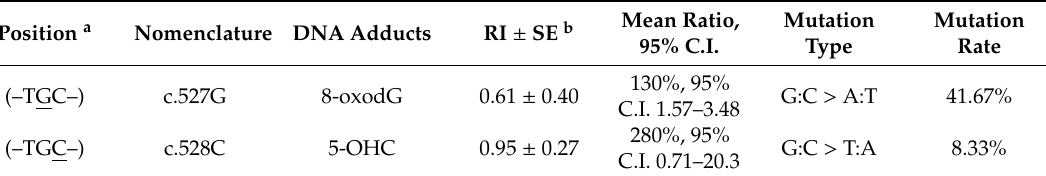
Relationship between the levels of 7-hydro-8-oxo-2 (cid:48) -deoxyguanosine (8-oxodG) and 5-hydroxycytosine (5-OHC) at the codon 176 along the exon 5 sequence of the p53 gene among hepatitis C virus (HCV)-associated hepatocellular carcinoma (HCC) patients and the spectrum of transition and transversion p53 mutations in HCV-associated HCC tumors. Mean Ratio (MR) and 95% Confidence Interval (C.I.) are shown. Position a Nomenclature DNA